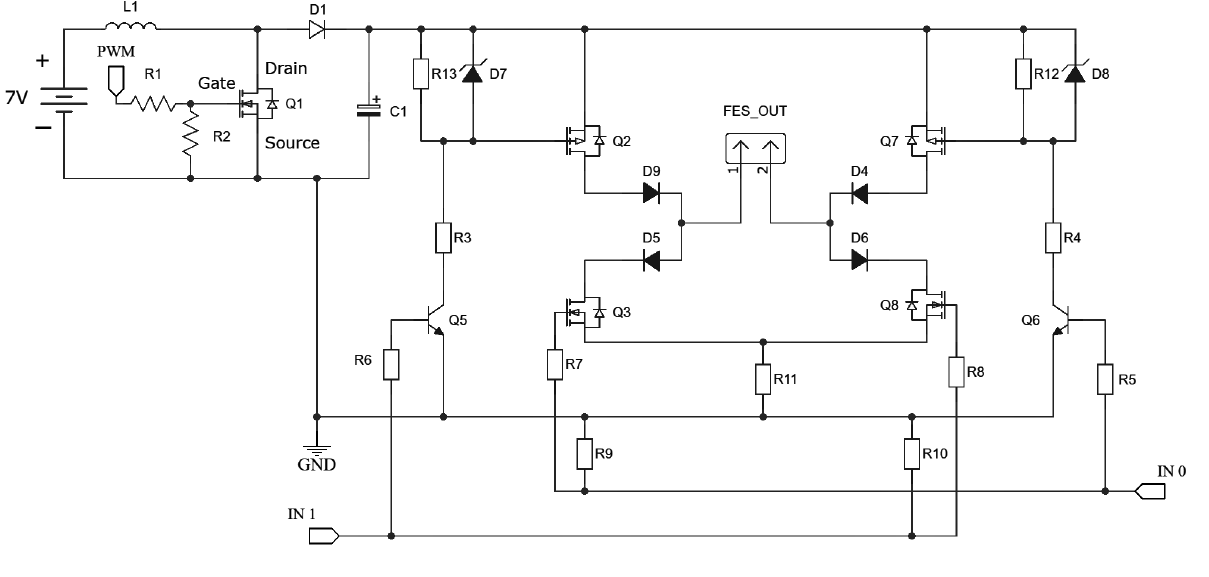
Figure 3. Electrostimulator circuit. The designed circuit has two parts. The first one is the boost that amplifies the 7 V input voltage accordingly to the PWM input in Q1. After the D1-C1 node, there is a connection from the boost to the